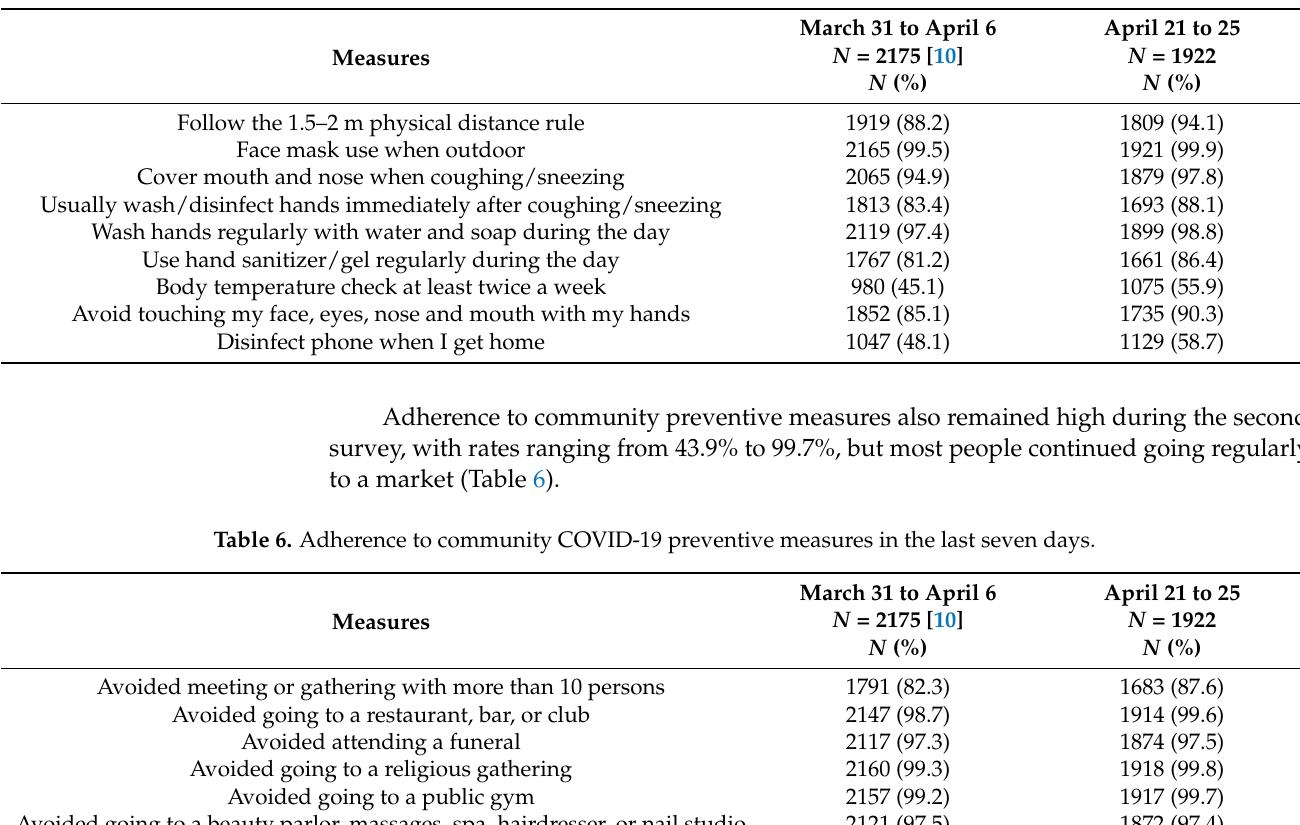
Table 5. Adherence to personal COVID-19 preventive measures.